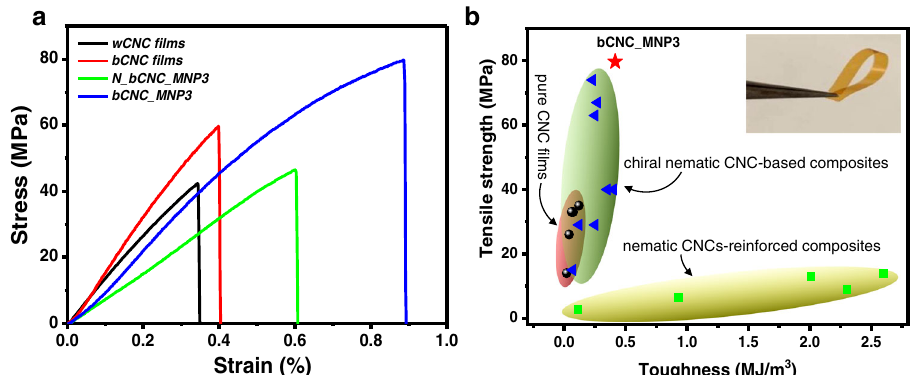
Fig. 6 | Mechanical performance of reinforced magnetic fi lms. a Stress – strain curves of wCNC fi lms, bCNC fi lms, N_bCNC_MNP3 and bCNC_MNP3 composite magnetic fi lms. b Ashby plot of tensile strength vs toughness of the bCNC_MNP3